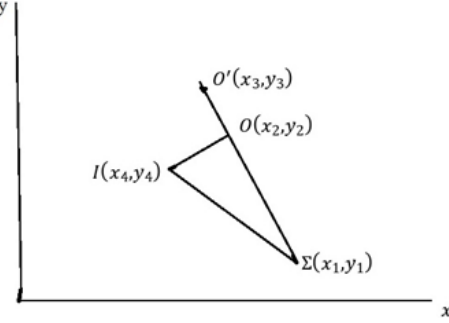
Figure 2. The Metrics of the Contradiction